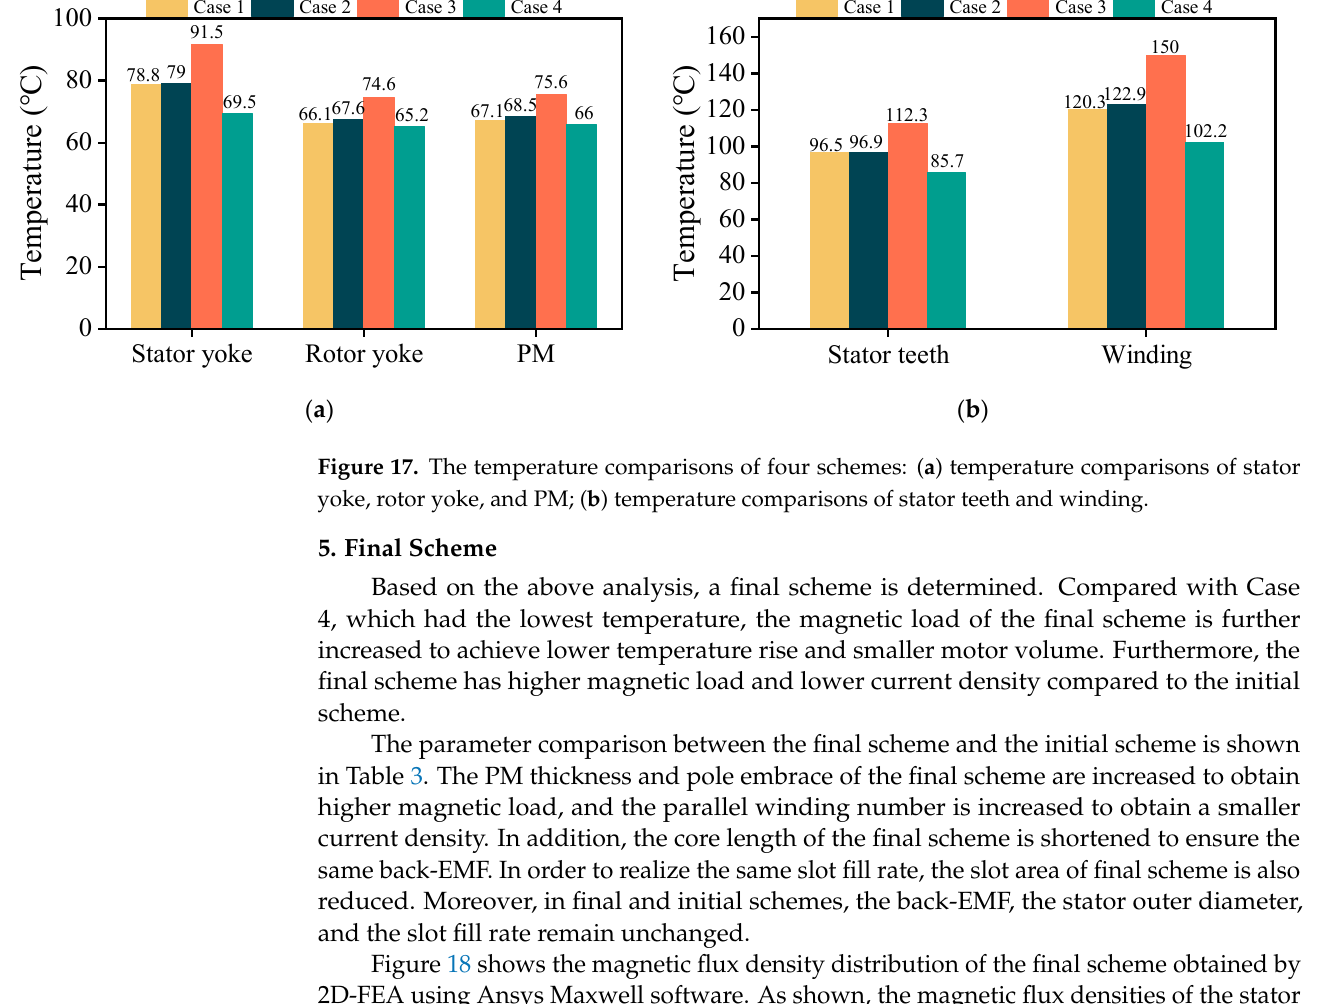
Table 3. The parameters comparisons of the final and initial schemes.